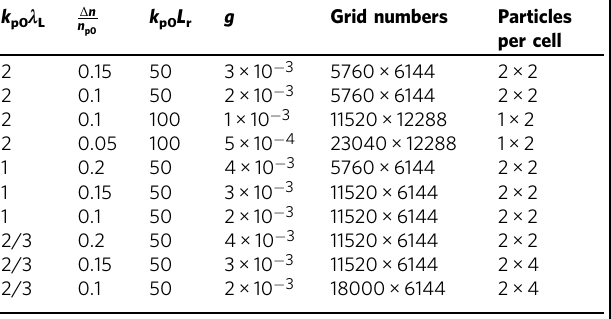
Table 1 Parameters of the results in Fig.